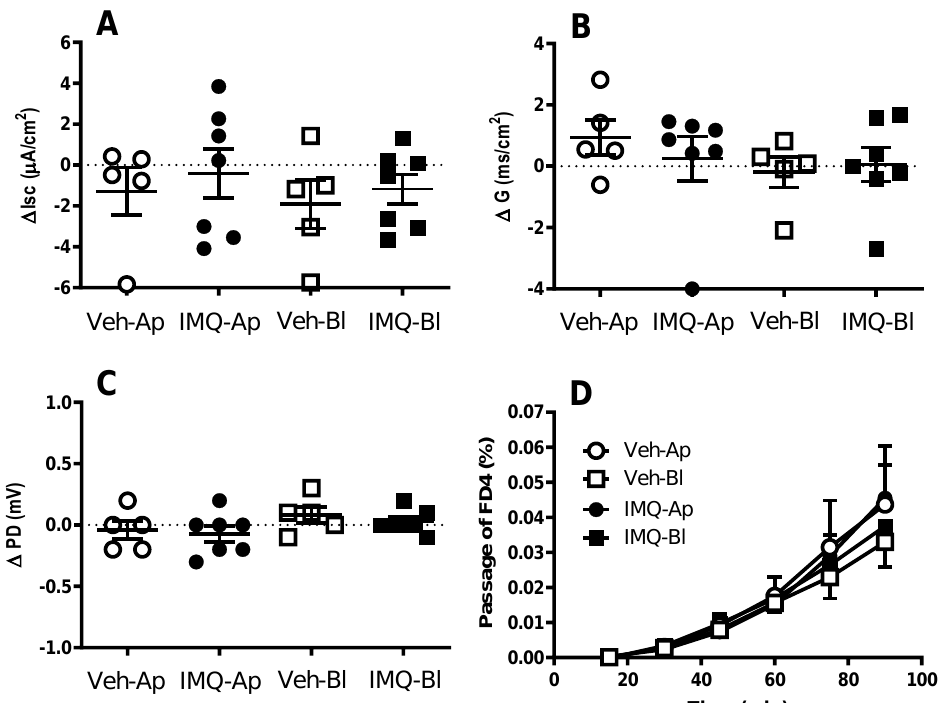
Figure 1. The effects of the acute addition of imiquimod (125 µM, IMQ) or its vehicle (0.5% hydrox- ypropylmethyl cellulose, Veh) to the Ussing chamber, either to the apical (Ap) or the basolateral (Bl) side, on the colonic epithelial electrical parameters and permeability to macromolecules. ( A – C ) the net change in epithelial electrical parameters: short circuit current (I sc , panel A ), conductance (G, panel B ), potential difference (PD, panel C ). Each point represents a colonic sheet, and the horizontal line with errors shows the mean ± SEM ( n = 5–7 colonic sheets from 5 animals per group). The net change (∆) was obtained as the difference between the value before and the value after the 60 min exposure to imiquimod. ( D ) Effects of imiquimod on epithelial permeability to macromolecules. The graph shows the mucosal to basolateral passage (as a percentage of the amount added to the mucosal reservoir) of fluorescein isothiocyanate-dextran 4 kD (FD4) in tissues exposed to Sthe vehicle (Veh) or imiquimod (125 µM, IMQ), either to the apical (Ap) or the basolateral (Bl) side. Data are mean ± SEM, n = 4 – 7 colonic sheets from 3 – 6 animals per group.